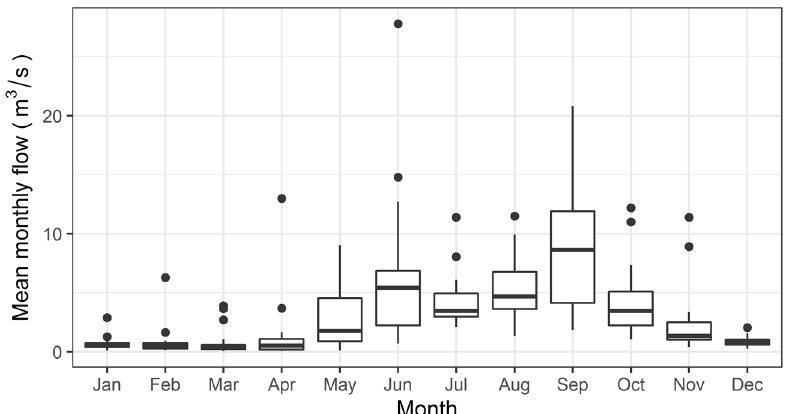
Fig. 3 Distribution of mean monthly flow